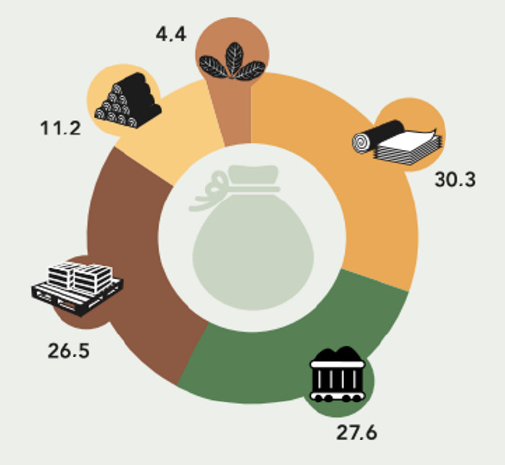
Figure 10. Percentage of distribution of groups of forestry products in the value of forestry production. Source: IBGE, Produção da Extração Vegetal e da Silvicultura 2021